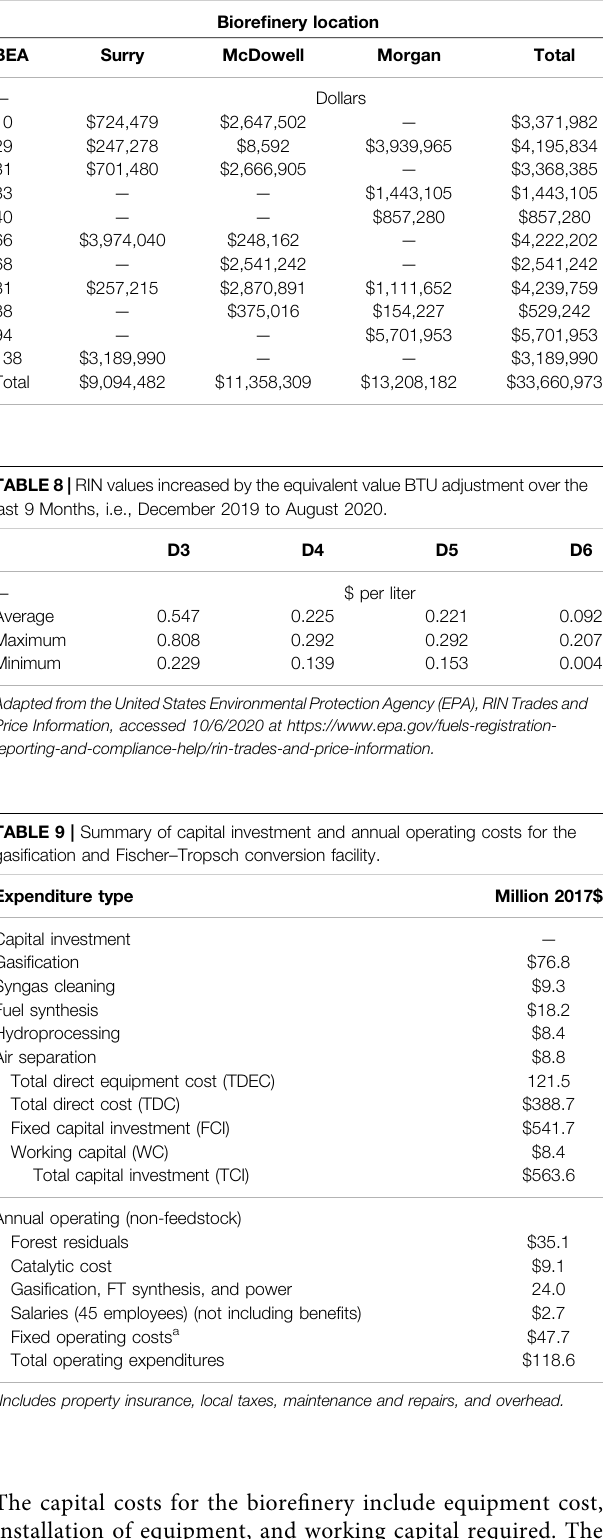
TABLE 7 | Cost to transport forest residues to biore fi neries by BEA.